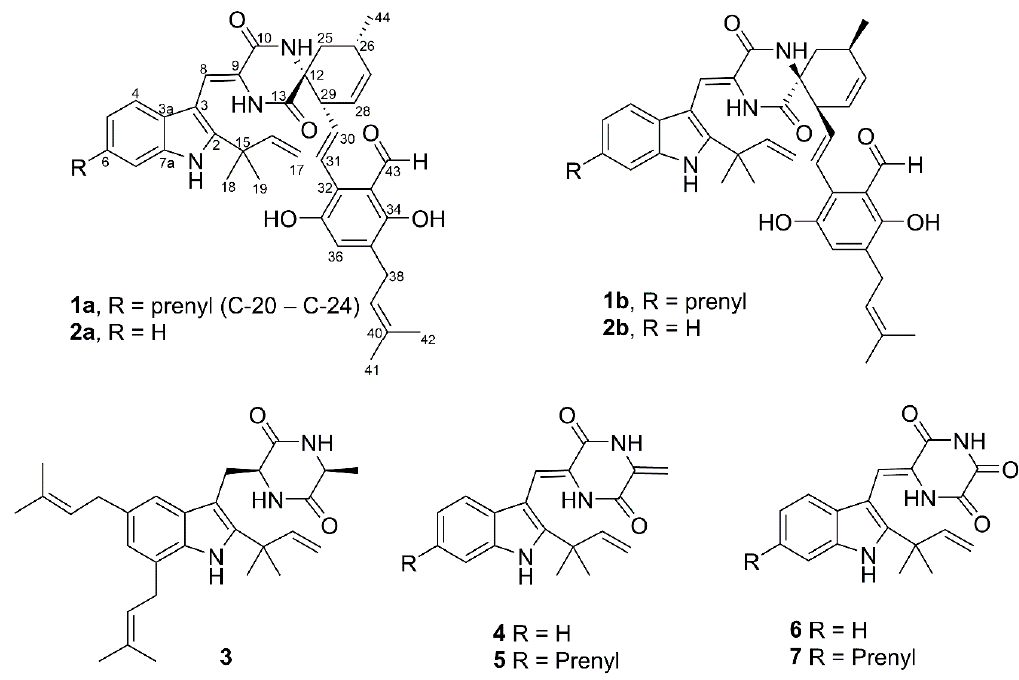
Figure 1. The structures of isolated compounds 1 – 7 .